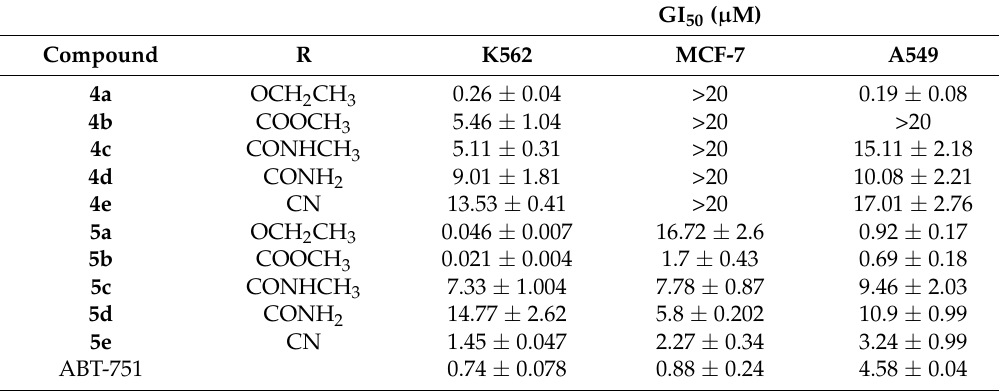
Table 1. Tumor cell growth inhibitory activity of 4a – e and 5a – e .